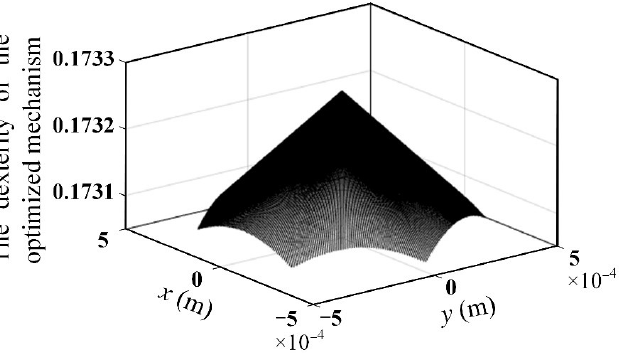
Figure 16. The distribution of dexterity within the maximum cross-section of the workspace of the optimized mechanism.